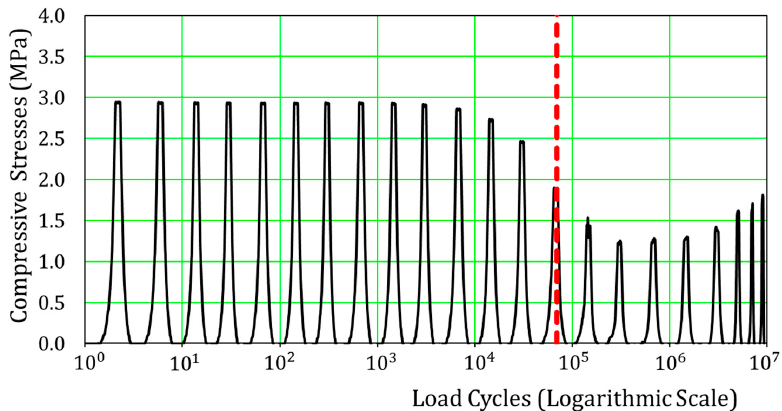
Figure 12. Load cycles and the top compressive stresses of the transverse direction of the central zone